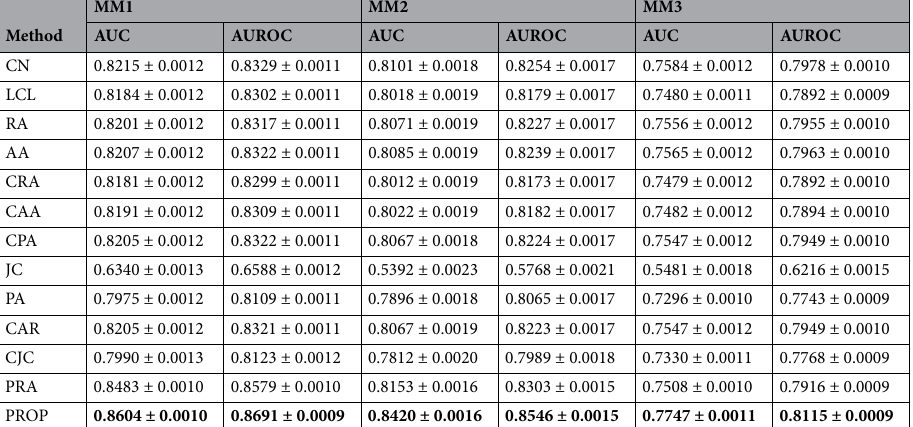
Table 3. AUC values of the proposed and alternate methods for the three multimorbidity datasets. Each experiment was executed 100 times and the average values along with the standard deviations are reported. Bold values indicate best performance.